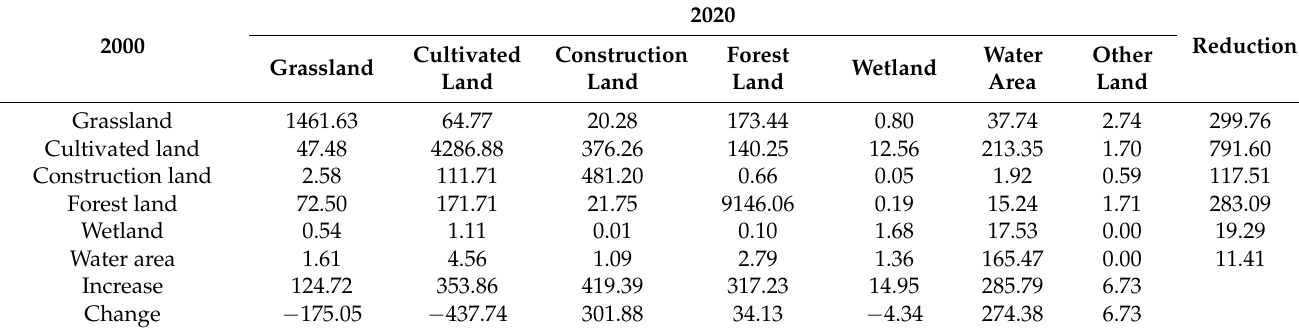
Table 3. Land use transfer matrix (unit: km 2 ).